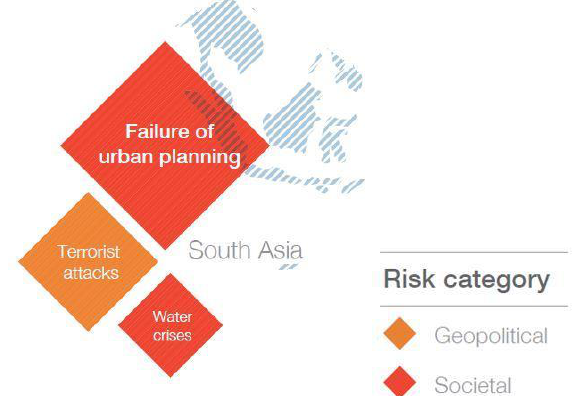
Figure 1. SEA risk perception survey map (Adapted from